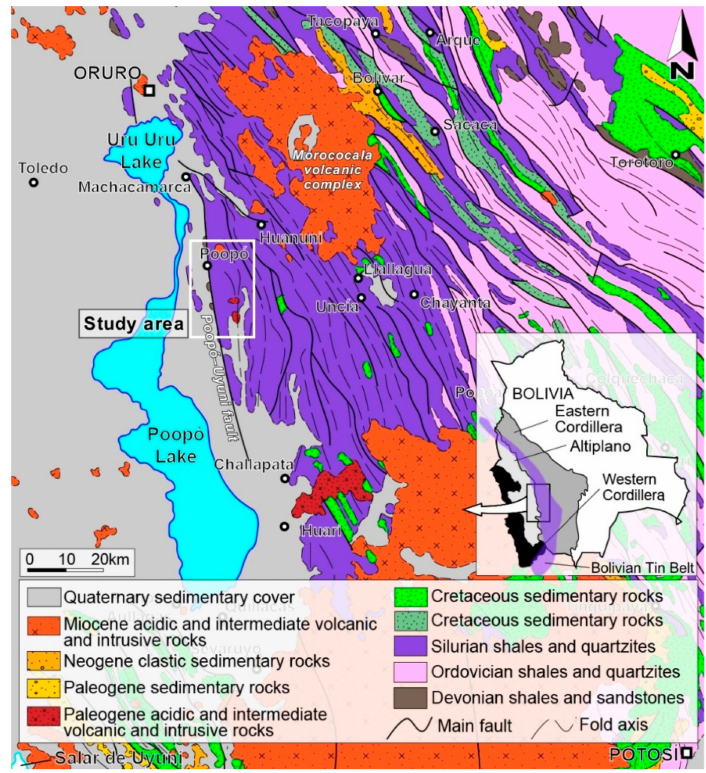
Figure 1. Regional geological map around the study area, adapted from Reference [7]. The distribution of the Bolivian Tin Belt was obtained from Reference